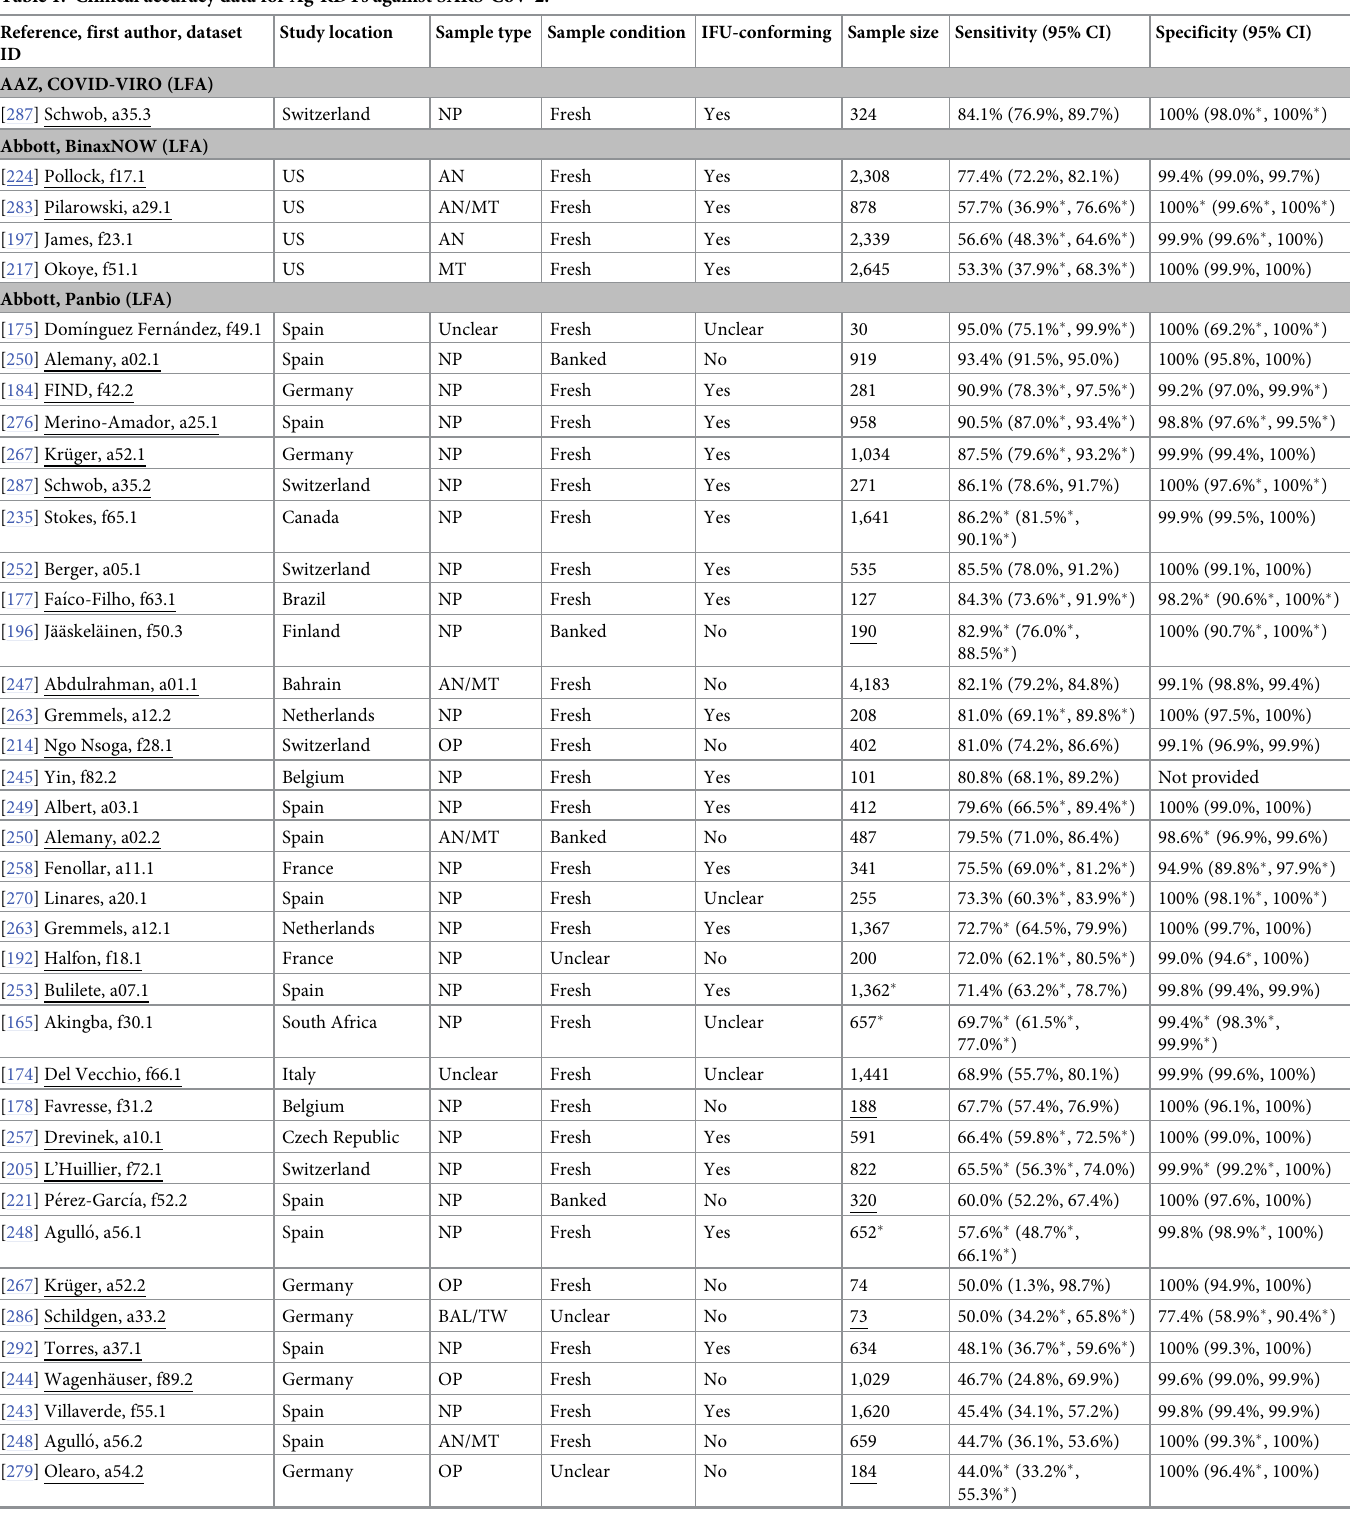
Table 1. Clinical accuracy data for Ag-RDTs against SARS-CoV-2. Reference, first author, dataset